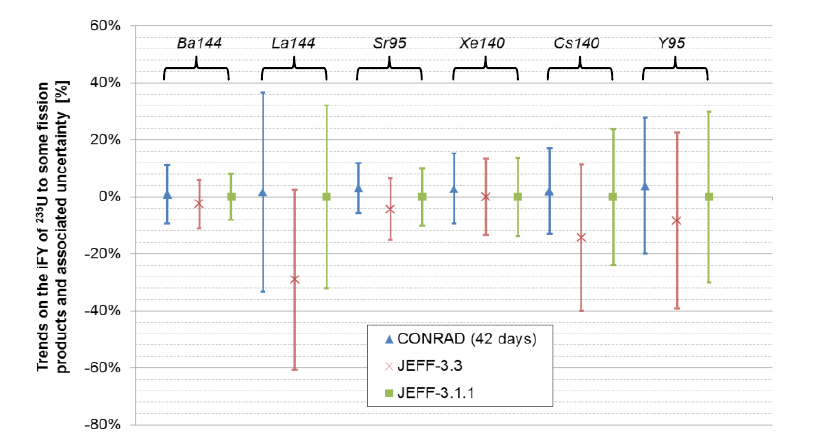
Fig. 1. Feedbacks on JEFF-3.1.1 independent fission yield (iFY) data after assimilation of the MERCI-1 experimental at 42 days of cooling with CONRAD and comparison to JEFF-3.3